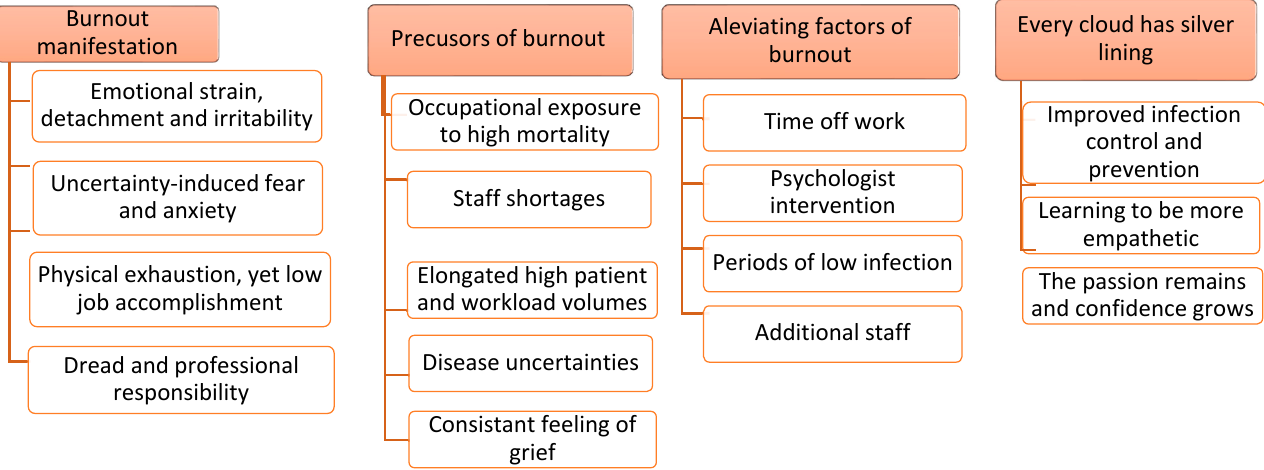
Figure 1. Themes and sub-themes from data analysis.